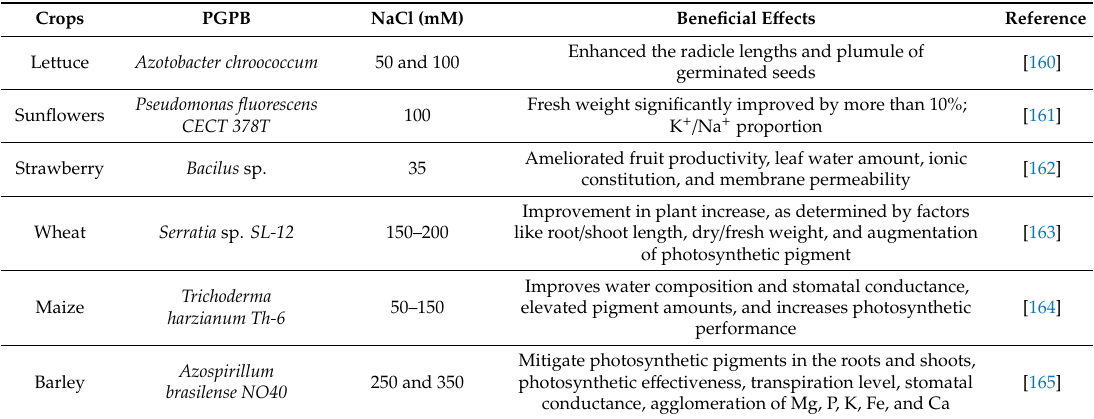
Table 1. Various roles of PGPB (Plant growth promoting bacteria) in enhancing yield and growth of di ff erent plants / crops under salt